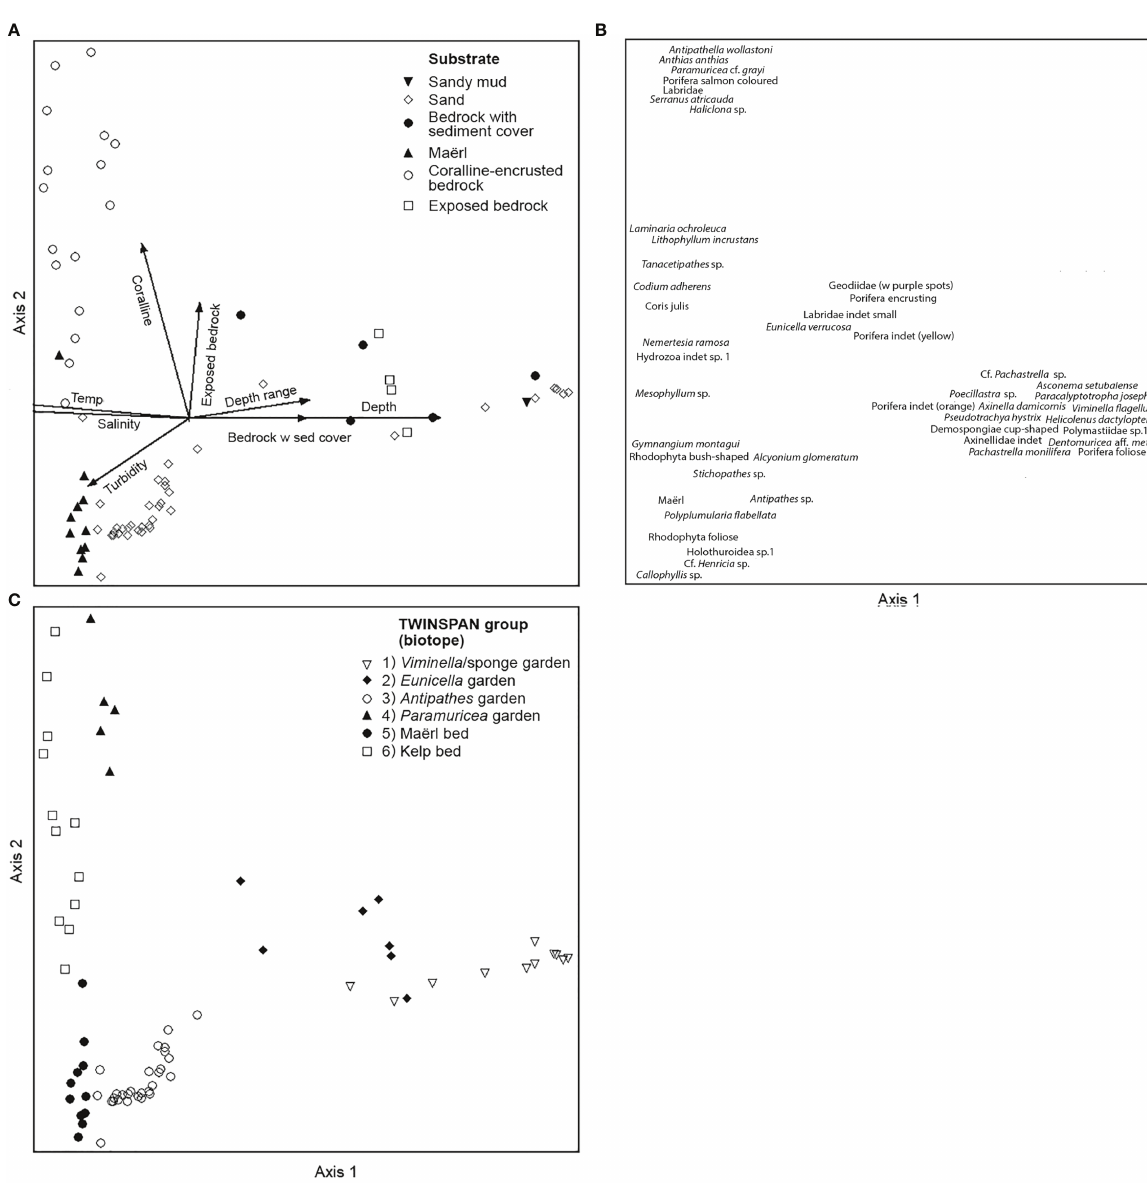
FIGURE 11 DCA plots from analysis of quantitative data (operational taxonomic units [OTU] and environmental factors) of 74 video samples, 48 OTU, and 21 environmental variables. (A) Biplot of samples (classi fi ed according to dominating substrate of the sample) and environmental factors shown as arrows (only factors with r > 0.4 are shown). (B) Species plot. (C) Plot with samples classi fi ed according to the result of TWINSPAN analysis of the same